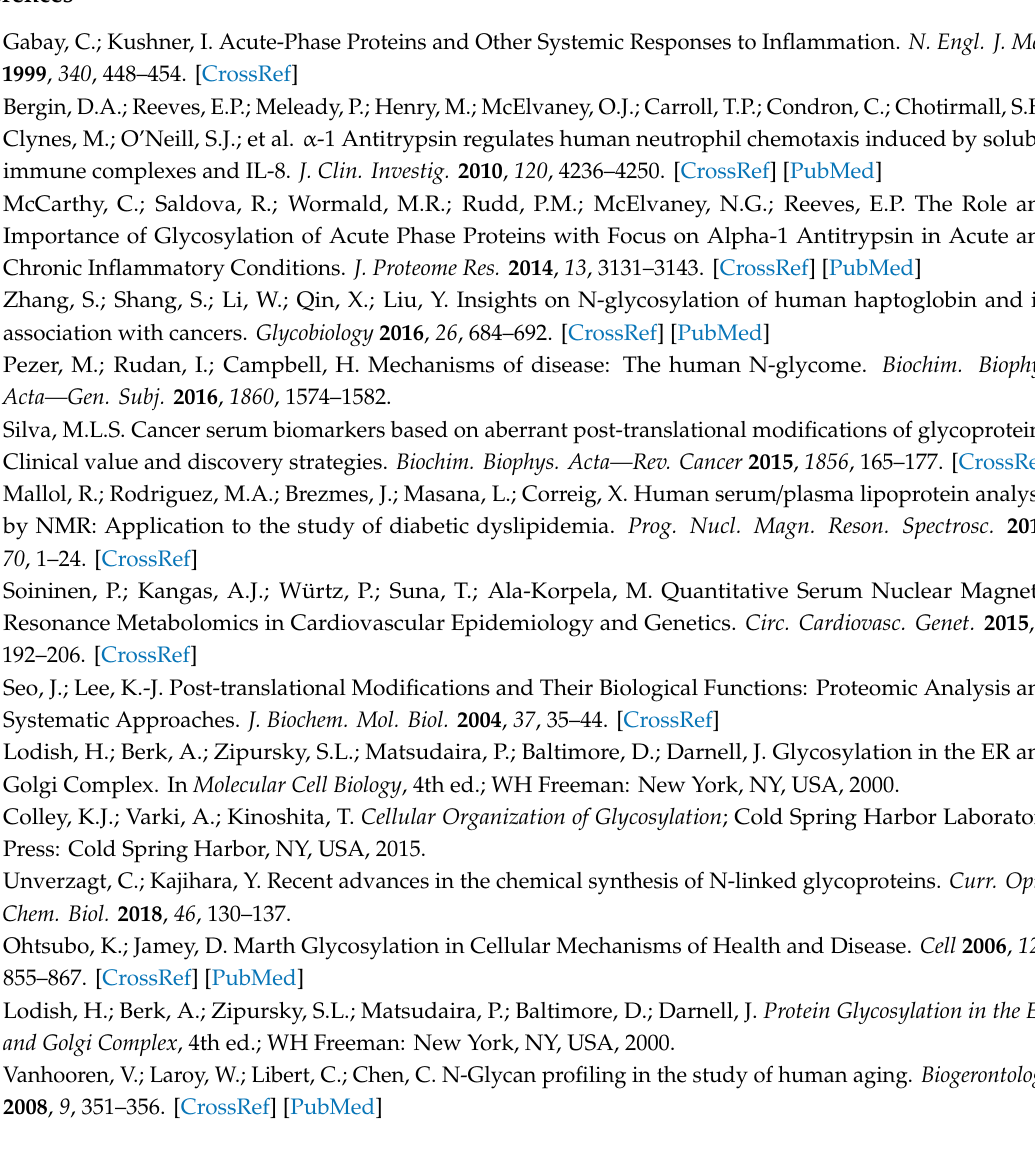
Table S1: Research articles related to the glycoprotein determination through 1H-NMR, Table S1—2: Metabolic Table S1—6: Cognitive function and psychological health, Table S1—7: Rare vascular diseases, Table S1—8: Table S1—15: Toxicity, Table S1—16: